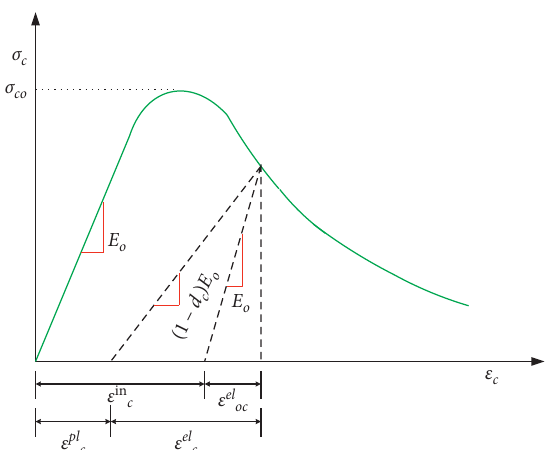
Figure 4: Stress-strain behavior of HFRC under compression.